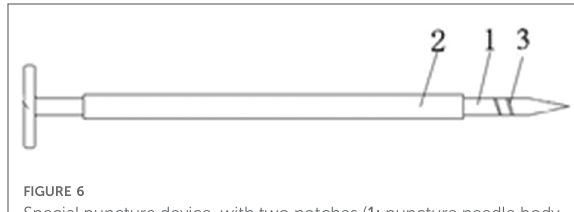
FIGURE 6 Special puncture device, with two notches ( 1: puncture needle body 2: sleeve fi tted to the outer side of the puncture needle body 3: notches located in the body of the puncture